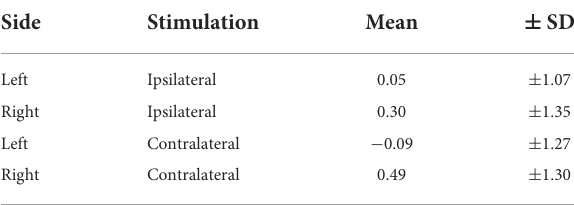
TABLE 3 Magnitude of the reference’s group–level z–statistics relative to the raters’